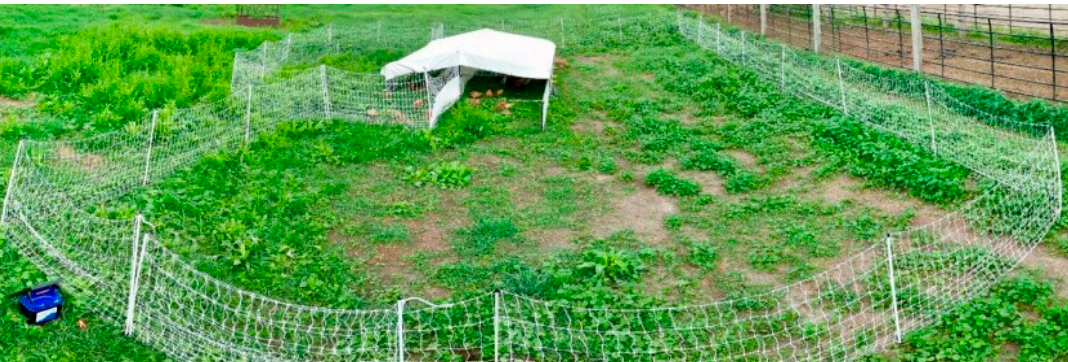
Figure 1. View of high ( left ) and low ( right ) outdoor stocking density treatment pens for replicate 1 birds on 27 June at 08:55. At the time this photo was taken, the average forage biomass for high- and low-density pens was 2.6 and 1.6 Mg/ha, respectively; and the average forage height for high- and low-density pens was 15.2 and 7.5 cm, respectively.